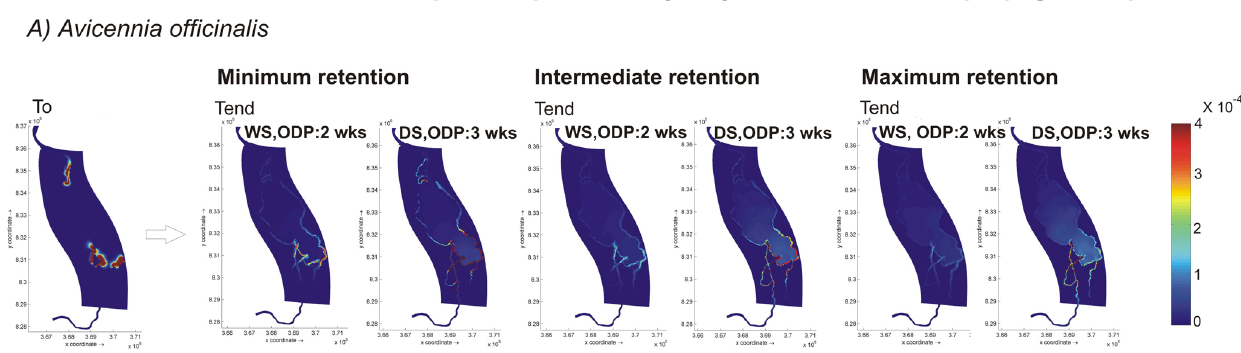
Fig. 5a. Results of scenario 1 (effect of species-specific buoyancy) showing the distribution plots of Avicennia officinalis . WS = wet season, DS = dry season, ODP = obligated dispersal period. Red, yellow and light blue colours indicate a high, medium and low concentration of propagules respectively.